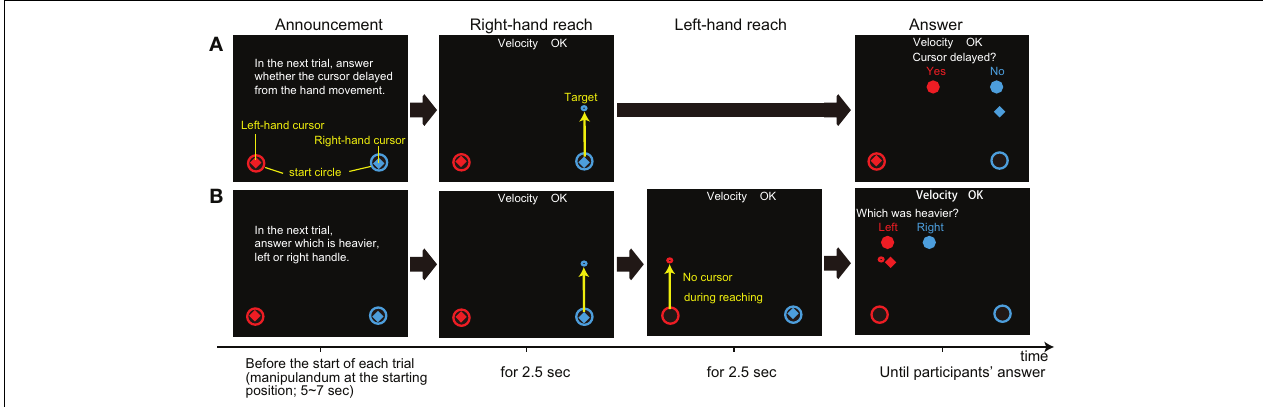
FIGURE 2 | Two types oftrialsinExperiment 2. Thehorizontal flow isthe sequenceofeachtrial; (A) Delayawareness trialinwhichsubjectswereaskedif they feltanydelay incursor movements, and (B) masscomparison trialsin whichsubjectswere askedtojudge whether theright- or left-handmovement